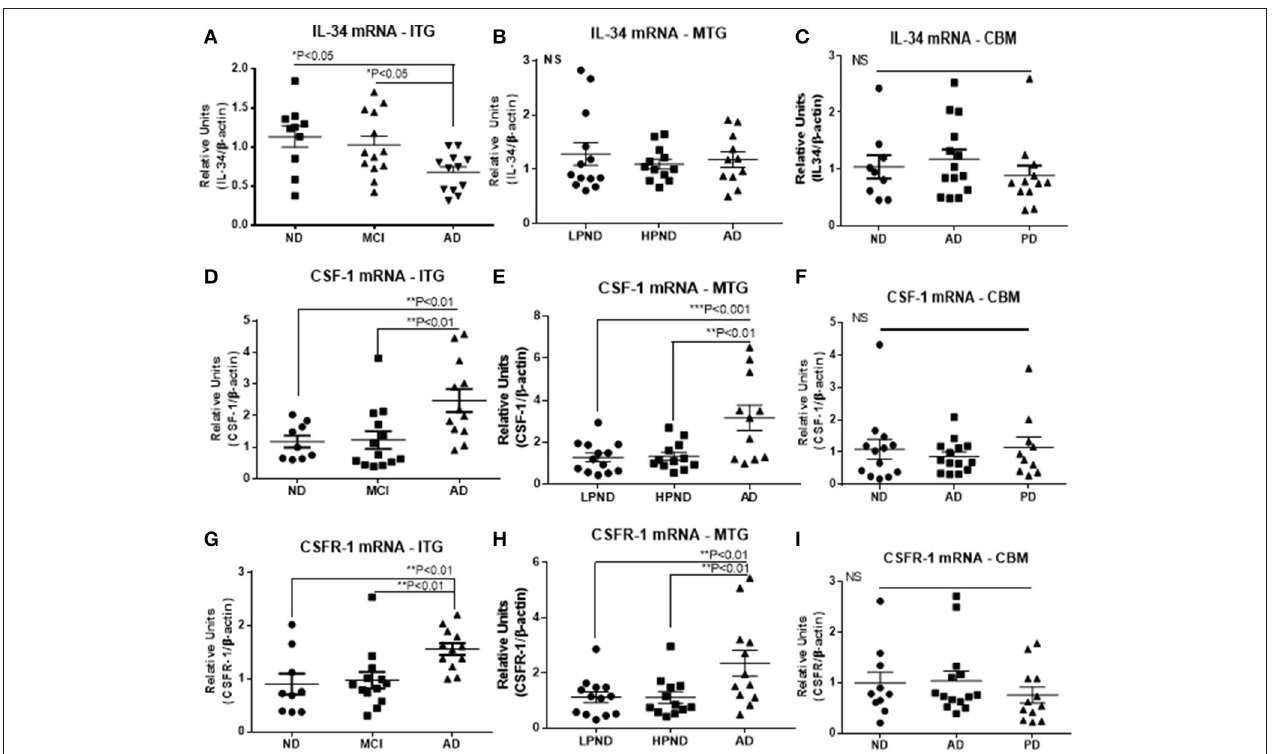
FIGURE 1 | Scatter plots for qPCR analyses of IL-34, CSF-1, and CSF-1R expression levels in inferior temporal gyrus (ITG), middle temporal gyrus (MTG), and cerebellum (CBM) brain RNA samples. Results on left side of figure show relative expression of IL-34 (A) , CSF-1 (D) , and CSF-1R (G) in ITG RNA samples from non-demented (ND), mild cognitive impairment (MCI), and Alzheimer’s disease (AD) cases. Results on figures show expression of IL-34 (B) , CSF-1 (E) , and CSF-1R (H) in MTG RNA samples from low plaque non-demented (LPND), high plaque non-demented (HPND), and Alzheimer’s disease (AD) cases. Results on right side of figure show relative expression of IL-34 (C) , CSF-1 (F) , and CSF-1R (I) in cerebellum RNA samples from ND, AD, and Parkinson’s disease (PD) cases. Data were analyzed by one-way ANOVA with Fisher LSD post-hoc test for between group significance. Bars on figures indicate mean ± standard error of mean (SEM) for each